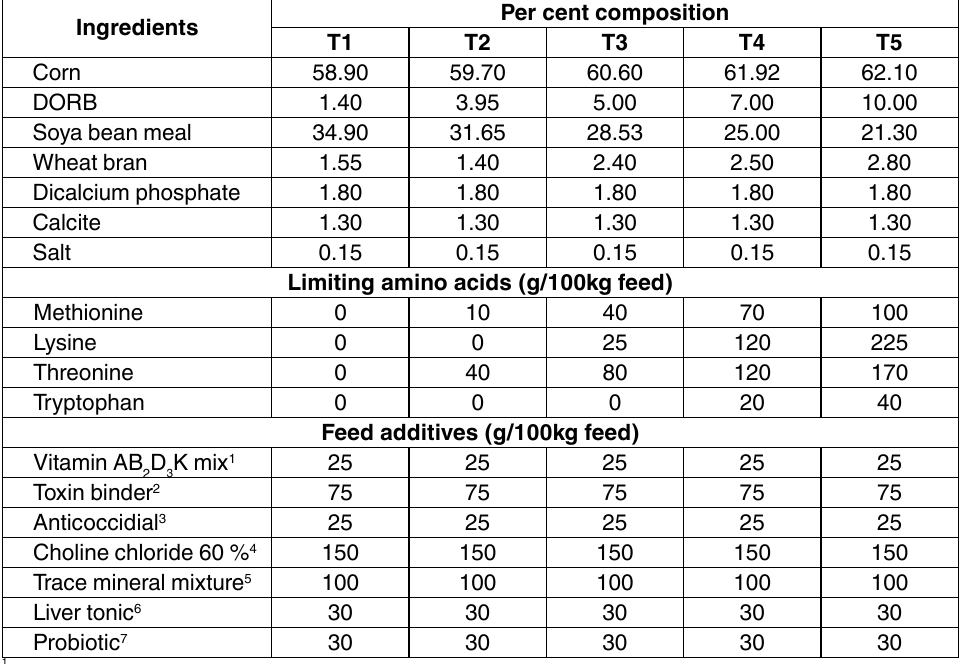
table 2. Ingredient composition of ration used in the trial Per cent composition ingredients t1 t2 t3 t4 Corn 58.90 DORB 1.40 Soya bean meal 34.90 Wheat bran Dicalcium phosphate Calcite Salt limiting amino acids (g/100kg feed) Methionine